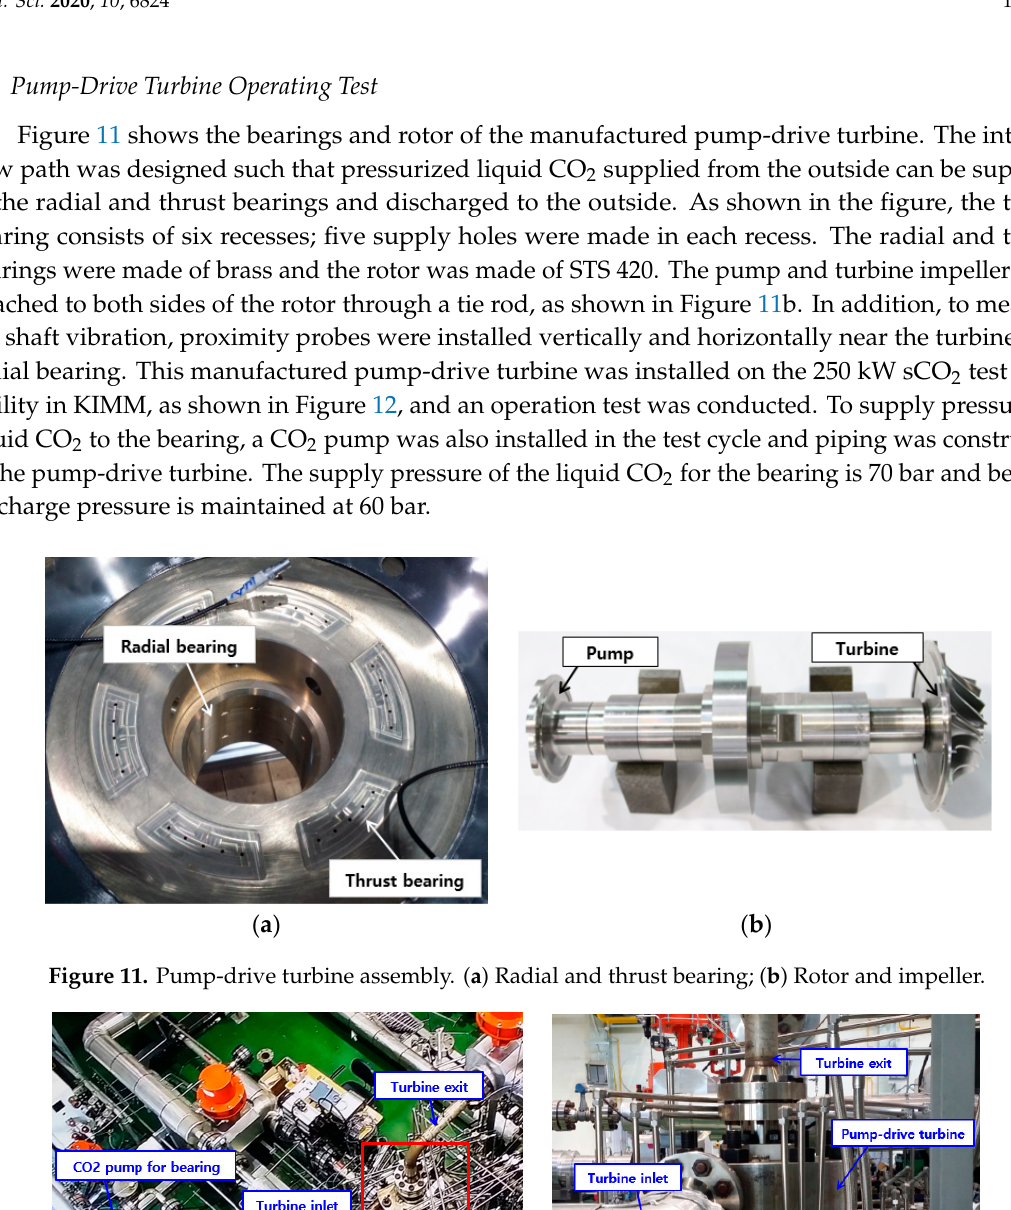
Figure 10. Predicted unbalance response at the two bearings (ISO G2.5).